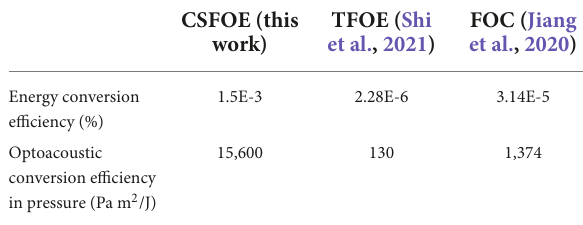
CSFOE (this work)